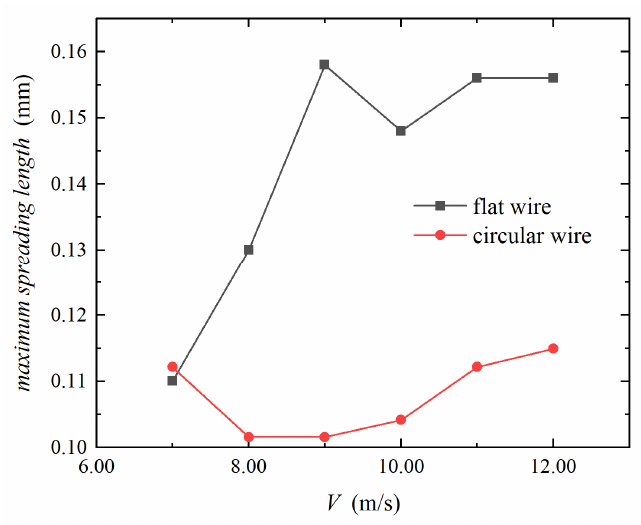
Figure 10. Droplet spreading length with different velocities.